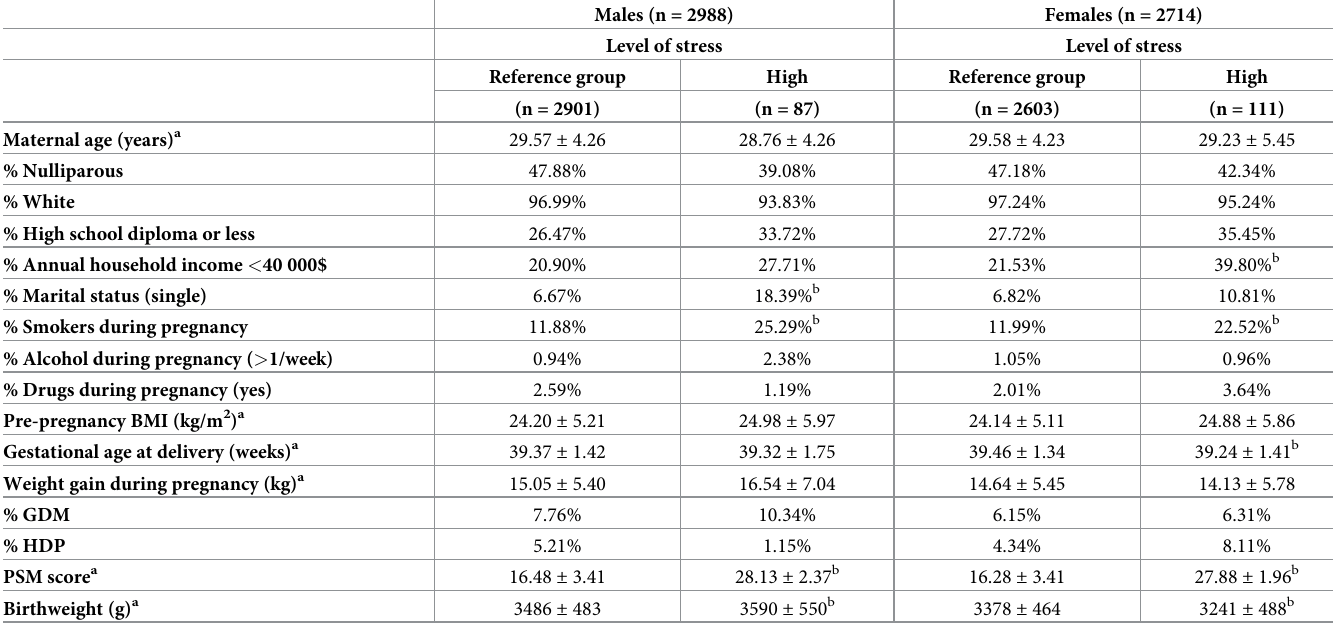
Table 1. Characteristics of mothers as a function of newborn sex and stress